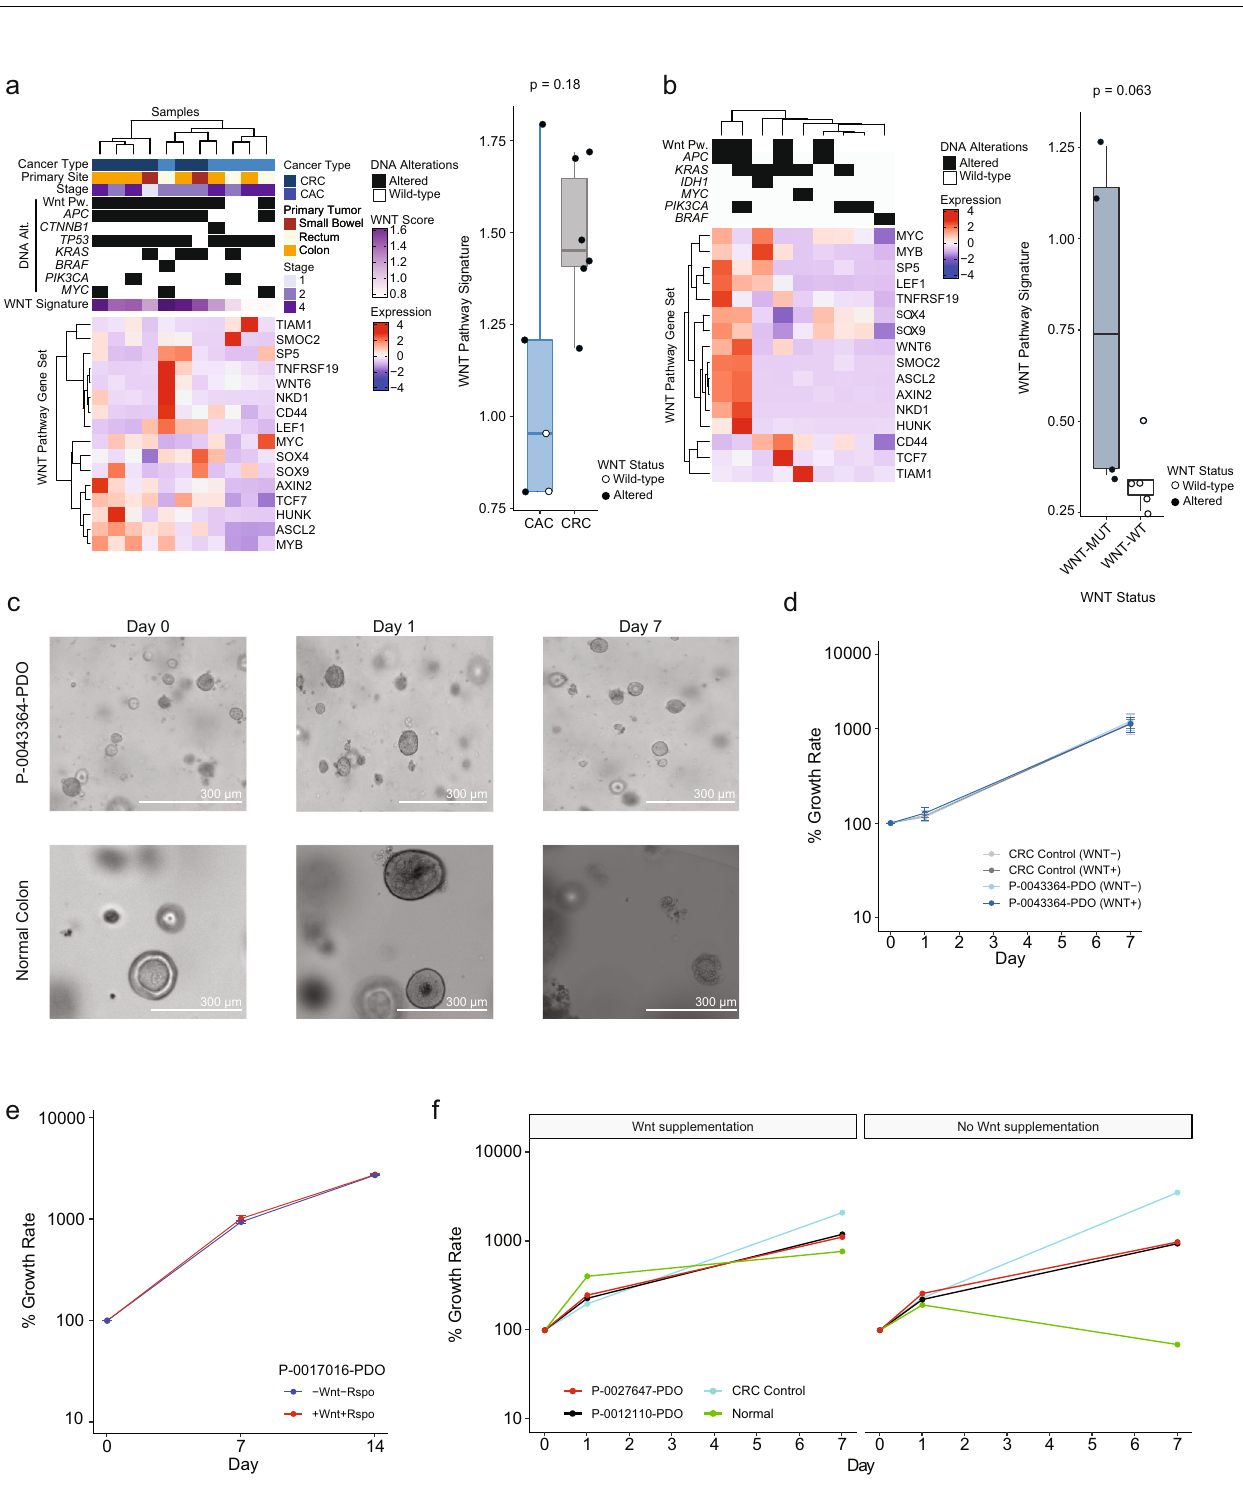
Fig. 1 | Clinico-genomic characteristics of colitis-associated cancers. a Clinical characteristics of 144 patients with CAC at time of CAC diagnosis. b Oncoprint showing recurrent genomic alterations in dysplasia ( n =29) and CAC ( n =166). Colors indicate type of genomic alteration and clinical characteristics as indicated in the legend below the oncoprint. c Frequency of KRAS alterations by CAC grade ( n =115). d Fraction of the patients who consented to germlinetesting ( n =73) who had germline alterations identi fi ed and the identity of these germline alterations. e Relative frequency of types of oncogenic changes in CAC and CRC ( n =166). f Frequency of focal and broad copy number alterations in CAC and CRC. Results